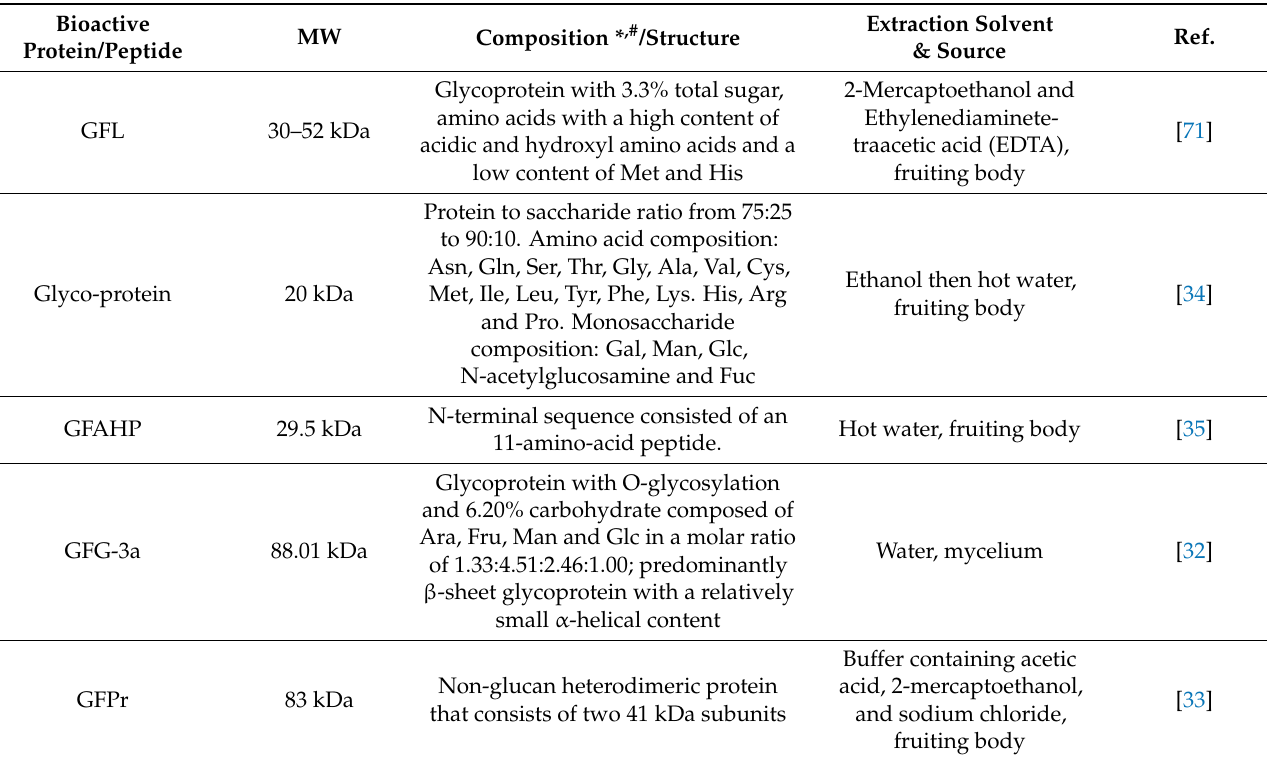
Table 5. Bioactive proteins and peptides isolated from G. frondosa with medicinal